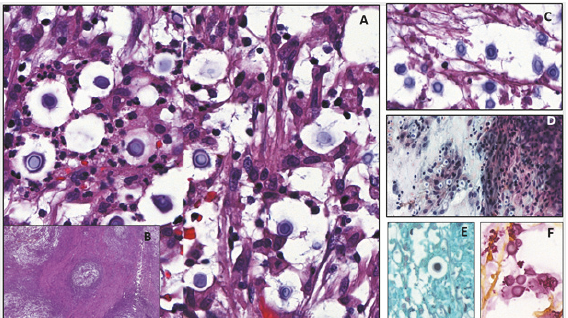
Figure 6: Microscopy slides: (A) Hematoxylin and eosin staining (H & E) observing spherical to oval yeasts with size variability. (B) Granulomas with peripheral fibrosis showing the chronicity of the process. (C) Larger increase in the center of the granuloma by iden- tifying numerous yeasts with thick capsules of mucopolysaccharide giving the characteristic appearance of having a free space around them. (D) FNA of supraclavicular lymph node showing multiple spherical yeast structures. (E) Grocott-methenamine silver (GMS) positive staining highlighting the wall of the fungus. (F) Positive mucicarmine staining by radiating the fungus